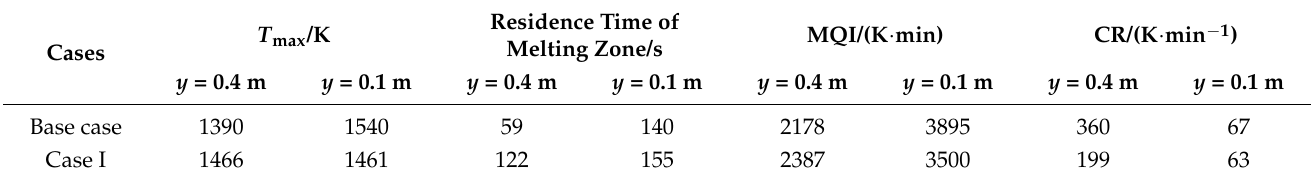
Table 4. Some parameters from temperature curves for the CS and FSDS